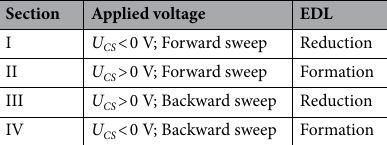
Table 1. Division of the transfer characteristic according to the applied potential and the appropriate EDL.